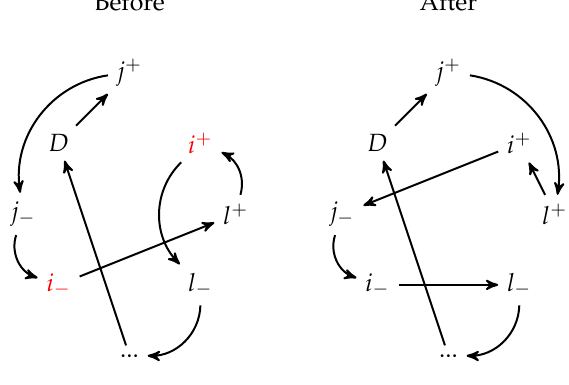
Figure 3. Repair-Destroy Arc